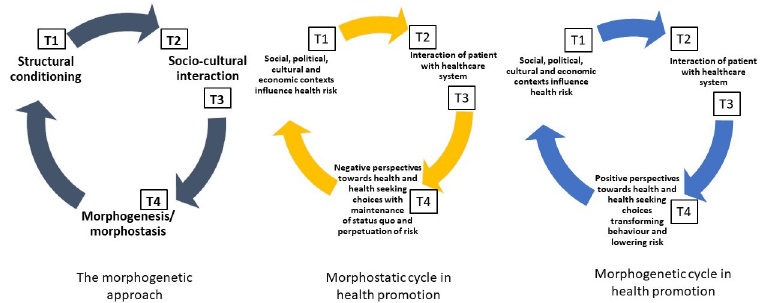
Fig 1. Theorizing choice in health promotion though the morphogenetic